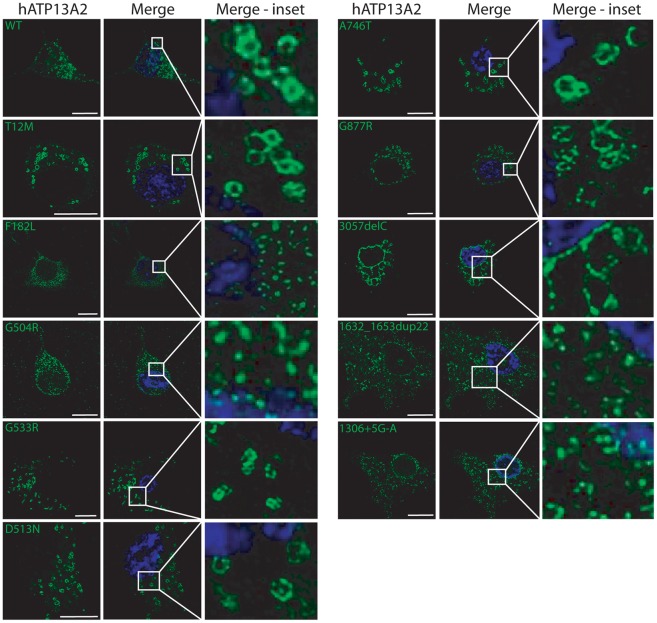
Homozygous missense mutations disrupt the vesicular membrane localization of ATP13A2.Confocal fluorescence microscopy reveals the cytoplasmic vesicular localization of V5-tagged human ATP13A2 variants transiently expressed in rat primary cortical neurons. WT or missense mutant (T12M, D513N, G533R, A746T or G877R) forms of ATP13A2 adopt a similar localization to large vesicular membranes, whereas F182L and G504R missense mutants or KRS mutants (3057delC, 1632_1653dup22 or 1306+5G→A) abnormally localize to small diffuse punctate structures. Staining for ATP13A2 (anti-V5 antibody, green) and nuclei (DAPI, blue) are indicated. Confocal images are taken from a single z-plane at 0.15 µm thickness. Images are representative of at least two independent transfection experiments. Scale bar: 10 µm.